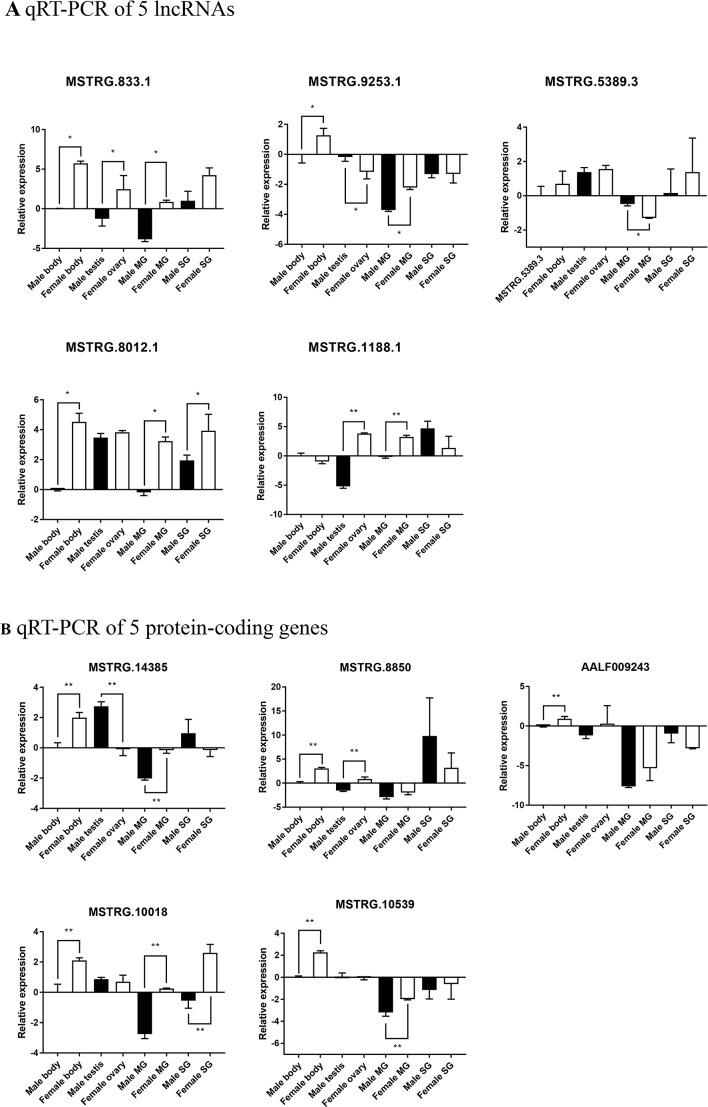
qRT-PCR-based quantitation of male and female lncRNAs and protein-coding genes with significant differential expression levels in whole body, sex organs, MG, and SG. Relative expression levels of (A) five lncRNAs and (B) five protein-coding genes. Data represent mean ± standard deviation, *P < 0.05, **P < 0.01.